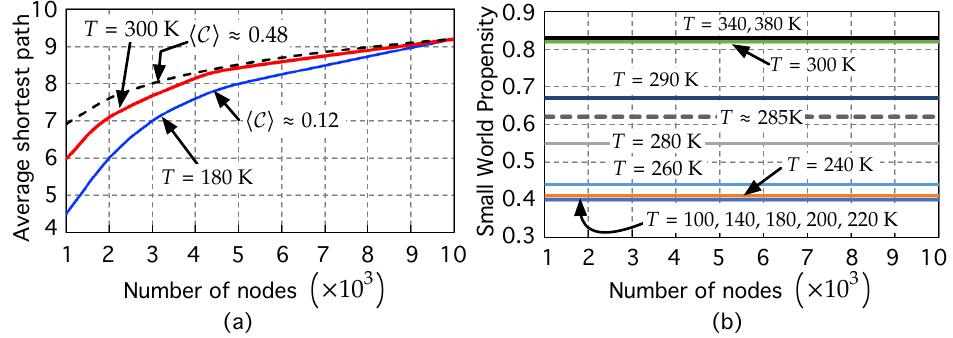
Figure 4. ( a ) Normalized mobility (with respect to the value of room temperature) as a function of temperature T (K). ( b ) Small World Propensity as a function of T (K). See the main text for further